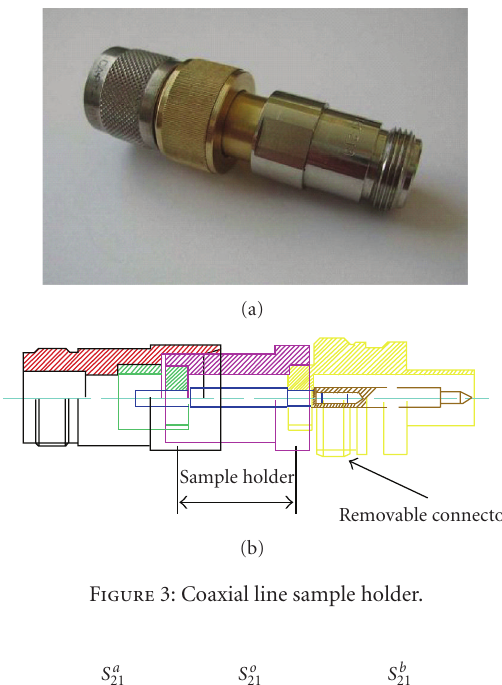
Figure 3: Coaxial line sample holder.